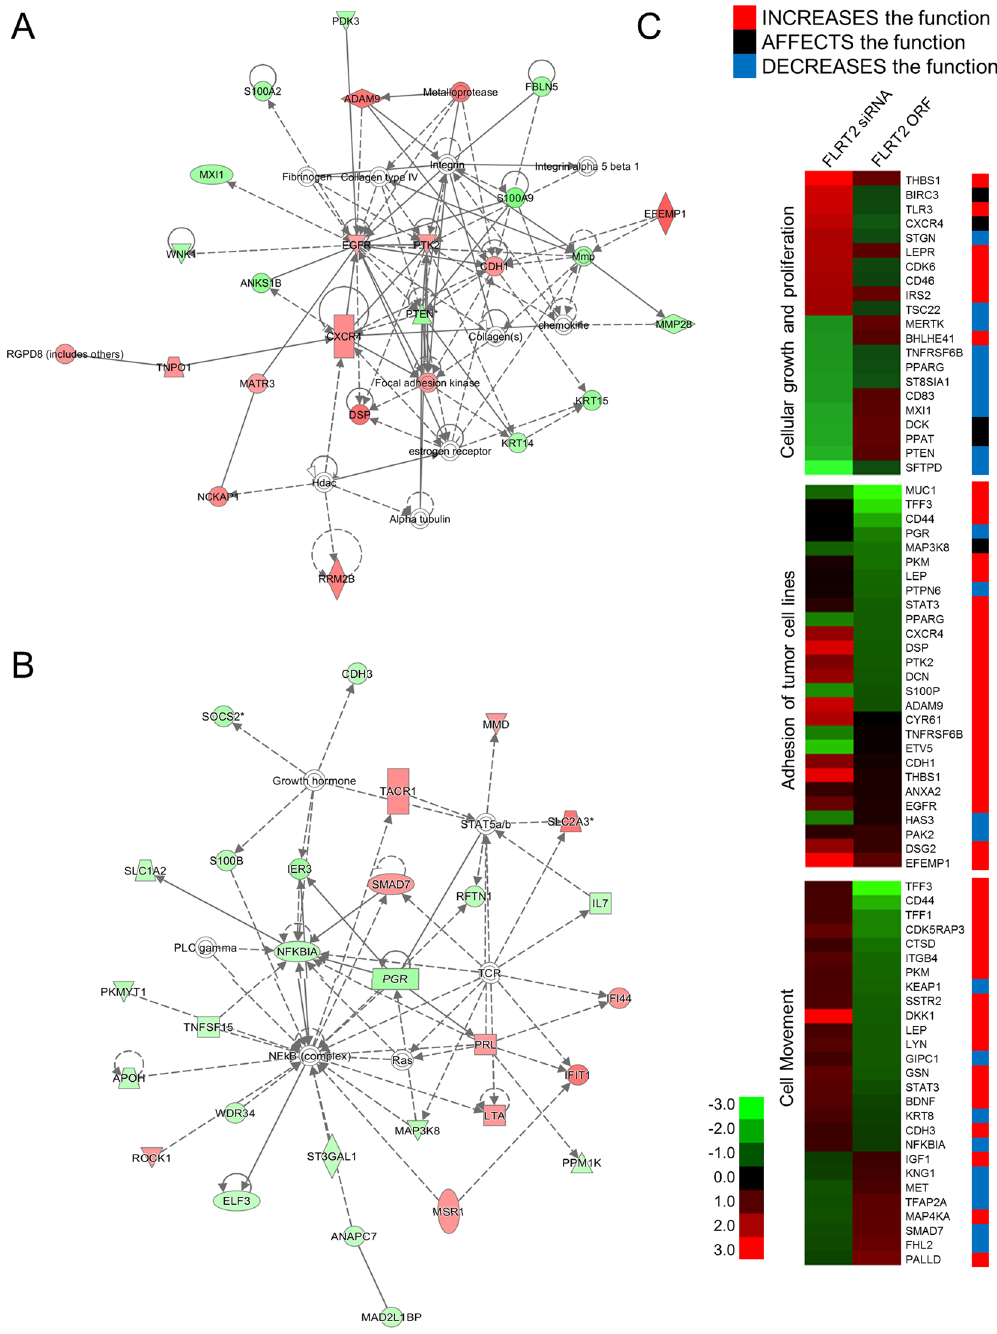
Figure 3. FLRT2 regulates genes as a way of inhibiting cell proliferation. Highest confidence IPA networks of genes displaying altered expression as a consequence of downregulating ( A ) and overexpressing ( B ) FLRT2. The top networks were “Infectious Disease, Auditory Disease, and Cancer” for downregulation ( A ) and “Infectious Disease, Cell Signaling, Cell-To-Cell Signaling, and Interaction” for overexpression ( B ). Upregulated genes are shaded in red, while downregulated genes are shaded in green, with the color intensity indicating the magnitude of the expression change. Solid and dashed lines respectively represent direct and indirect interactions. ( C ) Of the genes affected by FLRT2, genes related to “cellular growth and proliferation”, “adhesion of tumor cell lines”, and “cell movement” were clustered in heatmaps. The colored bar to the right of the gene symbol signifies the activity of the cellular biofunctions based on information from Qiagen (http://www.sabiosciences.com/ pathwaysonline/). Genes represented by red and blue bars exhibit expression changes in the direction of an increase and a decrease of the function, respectively. Genes in black bar are to affect the function, i.e., the genes are associated with biological function, but they have no direct effect on the